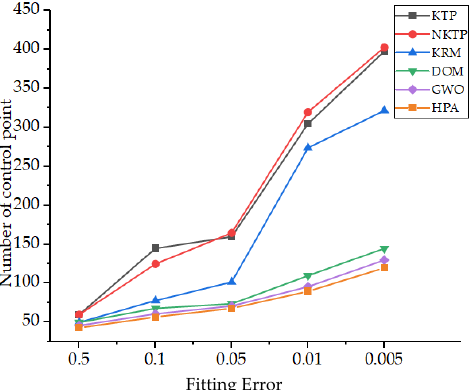
Figure 12. Comparison of control point number used at the same fitting error with DOM, KTP, NKTP, KRM, GWO and HPA .